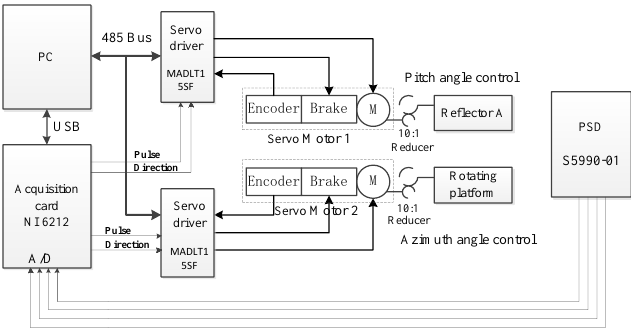
Figure 16. The schematic diagram of SOF-FTIR control system.